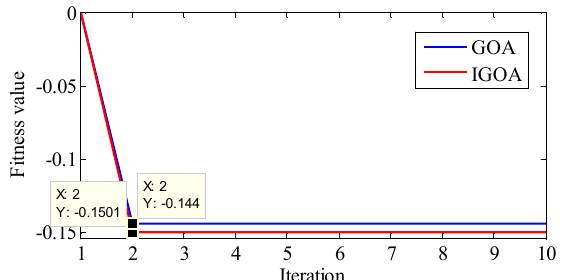
Figure 20. Time-domain and frequency-domain waveform of rolling element slight damage signal. TVF-EMD is optimized by IGOA and GOA, and the convergence curve is shown in Figure 21. The best fitness obtained by GOA is − 0.144, and the best parameters are ξ = 0.265544, n = 16. The best fitness obtained by IGOA is − 0.1501, and the best parameters are ξ = 0.223517, n = 11. It shows that IGOA has better optimization performance. The rolling element signal is decomposed by TVF-EMD optimized by IGOA, and the results are shown in Figure 22. IMF1 and IMF2 are high-frequency noise, IMF4 is close to 3Fi + Fr (516.5 Hz) in Figure 20, IMF5 is close to Fi, IMF6 is close to Fo, and IMF7 is close to rotational frequency Fr. The key components in the signal are effectively decomposed, and these components have specific physical meanings. The results show that the proposed method is effective.